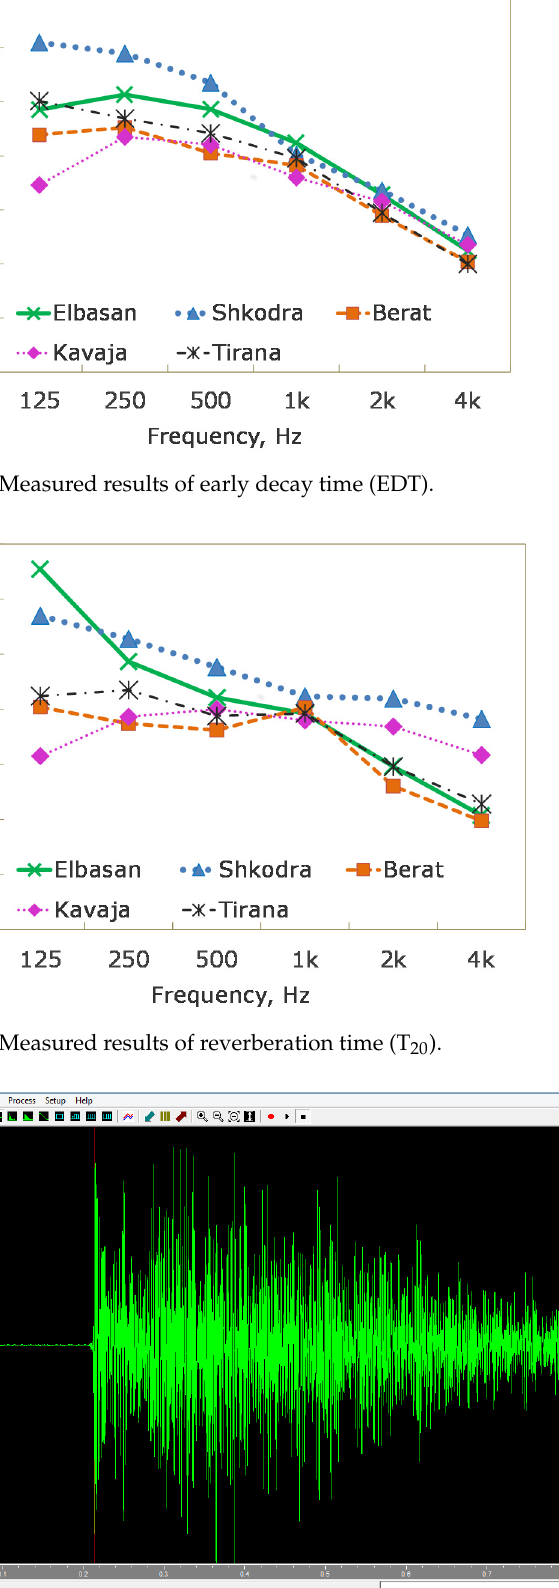
Figure 17. Impulse response measured inside the Naziresha Mosque of